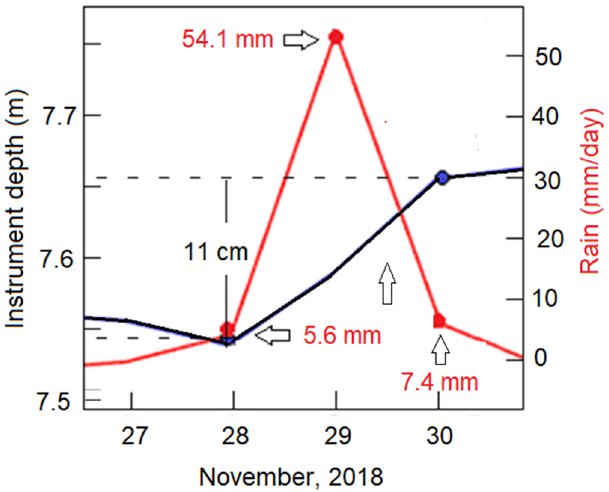
Figure 11. Daily precipitation (NMS data) and level values (TDR 2050 data) measured on 27–30 November 2018 at the time of heavy precipitation. This segment of observations corresponds to the red rectangle inn Figure 9a.